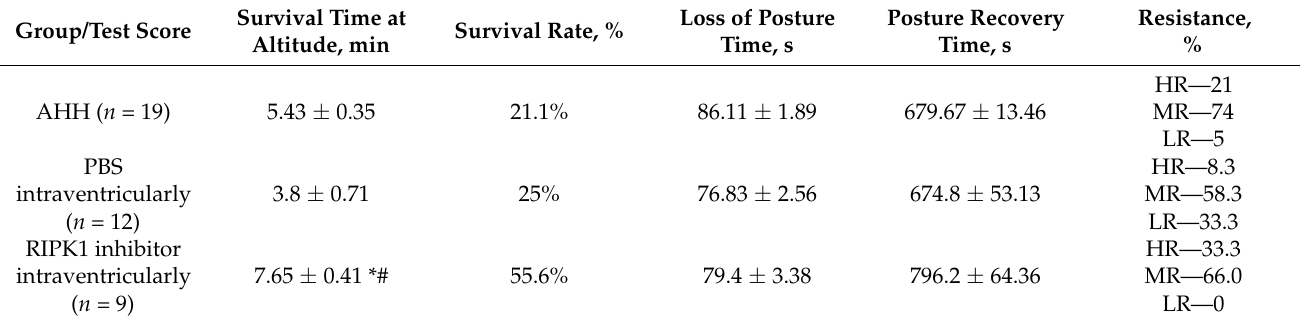
Table 1. The main indicators of animal resistance to acute hypobaric hypoxia (AHH).